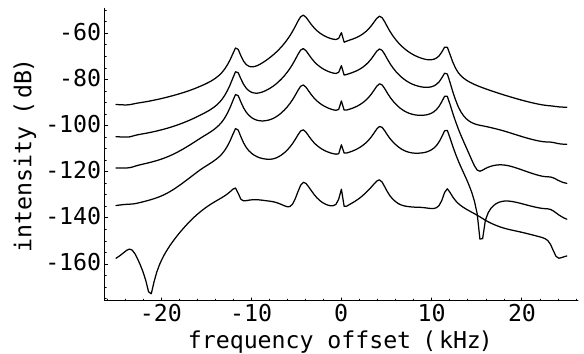
FIG. 13. Simulations of the response function T 55 55 of a 500 mA fully stretched bunch in a ring with VUV fundamental rf modes in the two cavities and no broadband impedance. The traces differ in their initial impulse p 0 in the momentum variable p (cid:1) d f (cid:3) dt applied with the cosine- f and sine- f dependence as part of the impulse-based calculation of response functions (Sec. III). These impulses are, from top to bottom, p 0 (cid:1) 10 , 30, 100, and 300 s 2 1 . Machine parameters are given in Table